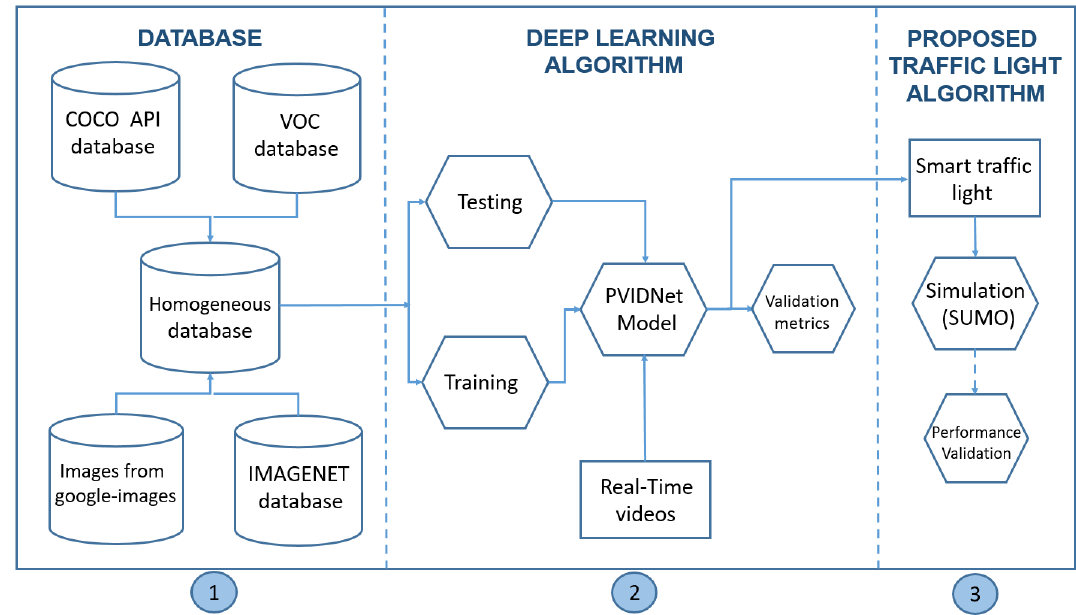
Figure 1. Flowchart of the proposed solution for the proposed intelligent traffic light.